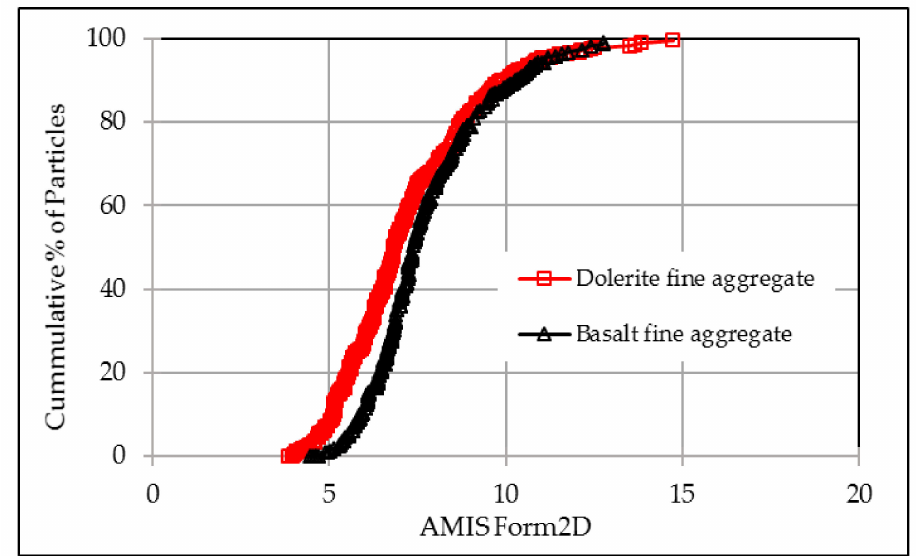
Figure 11. Form2D distributions of the used fine aggregates.